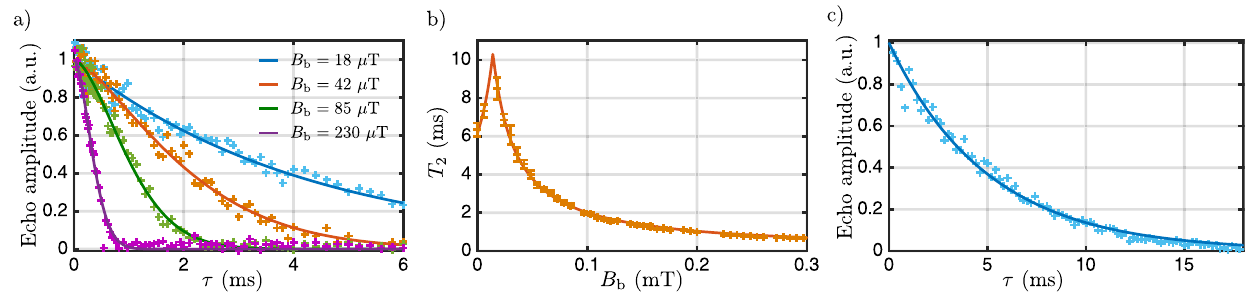
Fig. 4 Spin coherence time measurements. a Hahn echo decays for fi elds B b = 18, 42, 85, 230 μ T along the b-axis, with a constant offset fi eld ¼ (cid:3) 155 μ T to compensate for the lab bias fi eld along D fi ts to a stretched exponential. b Spin coherence times measured B D 2 . Solid lines show 2 along the b-axis. Error bars represent 95% con fi dence intervals. The solid line shows a simple empirical model (see text for details). c The longest Hahn echo decay was obtained by carefully adjusting the bias magnetic fi eld around the estimated ZEFOZ point, while optimizing the echo amplitude at a long delay, resulting in a spin coherence time of T 2 = (10.0 ± 0.4)